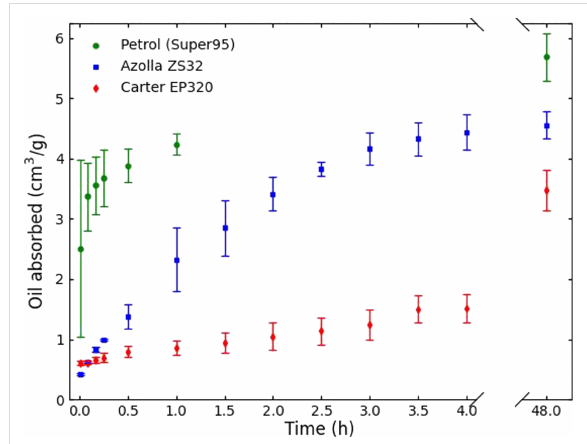
Figure 10: Oil absorption as a function of the time for pads filled with cotton and different oils. The higher the viscosity of the oil, the slower it is